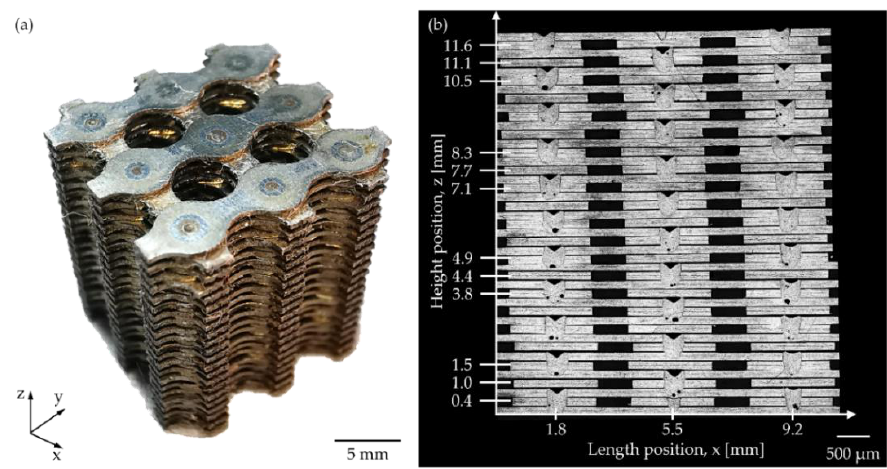
Figure 7. ( a ) Fabricated scaffold and ( b ) Metallography of the cross-section of the fabricated scaffold.